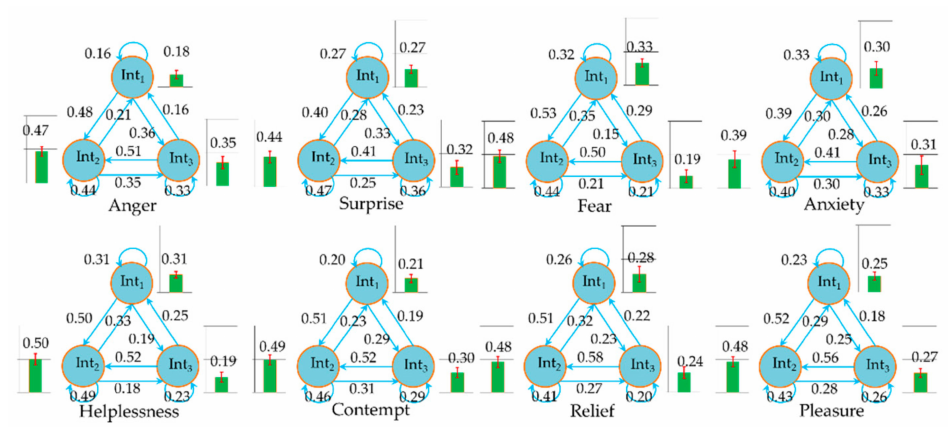
Figure 13. Transition probability between driver’s intention states in the di ff erent